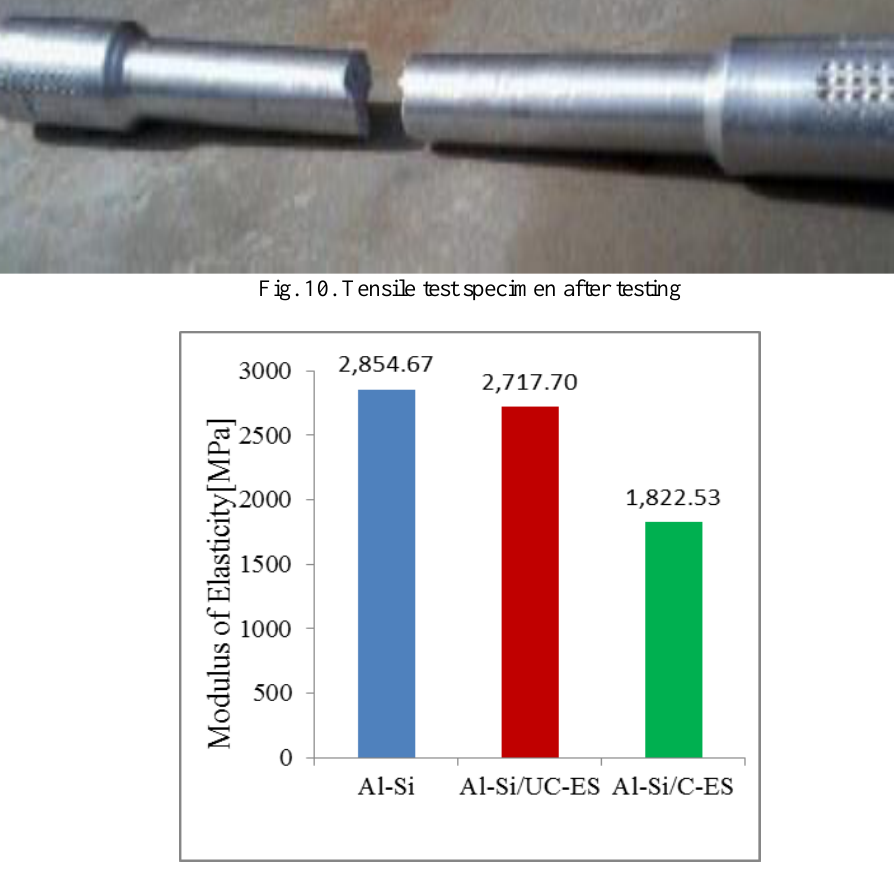
Fig. 11. Comparison of modulus of elasticity for control sample and the two